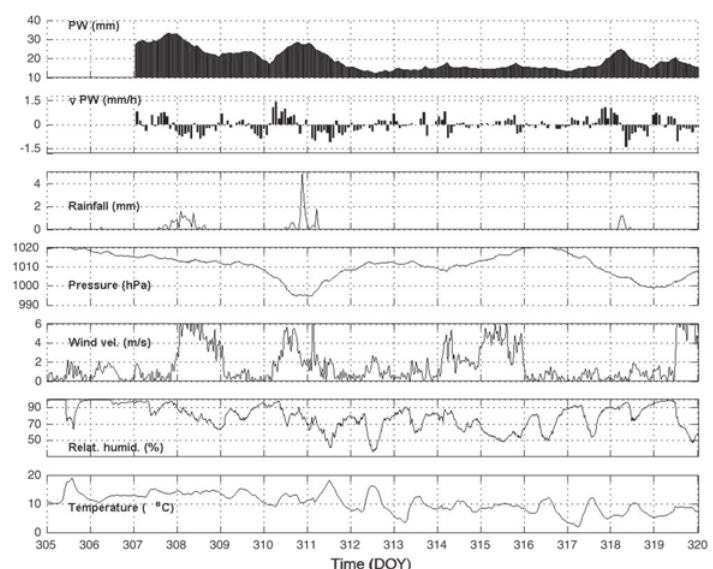
Fig. 4. Precipitable Water (PW, mm) and PW curve derivative coefficient sign ( ∇ PW, mm/h) for Padua; barometric pressure (hPa); wind velocity (m/s); relative humidity (%) and air temperature at 2m ( ° C) for Verona versus time for period of DOY 305-320, 01 November - 16 November, 1999.